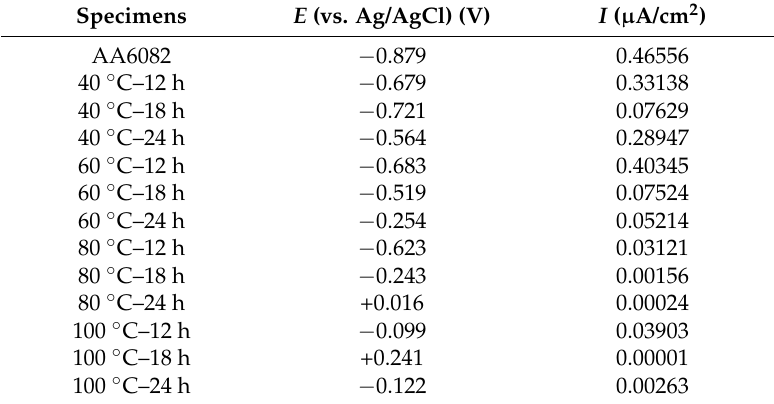
Figure 6. Polarization curves of bare AA6082 and the coated AA6082 in 0.1 M NaCl aqueous solution. Table 3. The electrochemical parameters estimated from the polarization data in Figure 6.